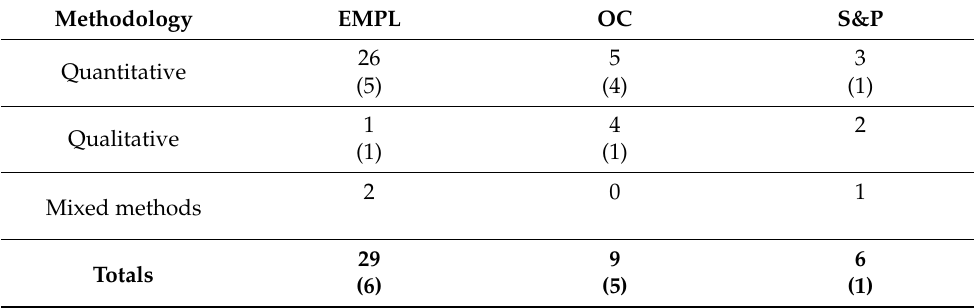
Table 1. Categorization of SO and methodology of reviewed